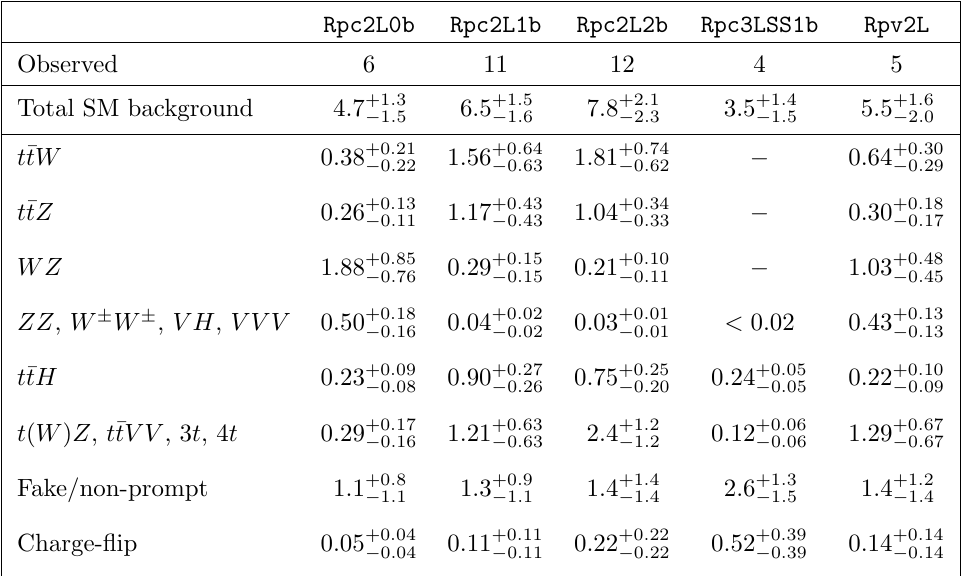
Table 5. Observed yields in data and expected contributions from SM processes (section 5) and the reducible background (section 6) to the (cid:12)ve SRs. The displayed numbers include all sources of statistical and systematic uncertainty; since some of the latter might be correlated between di(cid:11)erent processes, the numbers do not necessarily add up in quadrature to the uncertainty in the total expected background. The WZ and t (cid:22) tV processes cannot genuinely result in (cid:12)nal states with three same-sign leptons, so their contributions to the Rpc3LSS1b signal region are denoted by (cid:0) . Contributions to Rpc3LSS1b only include those from processes producing (cid:12)nal states with three genuine same-sign leptons, such as t (cid:22) tWZ or WZZ .